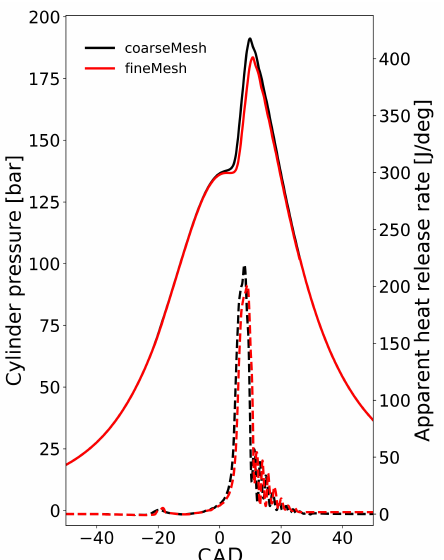
Figure 8. Comparison between CFD validation and PSO set-up in terms of pressure and heat release rate of baseline